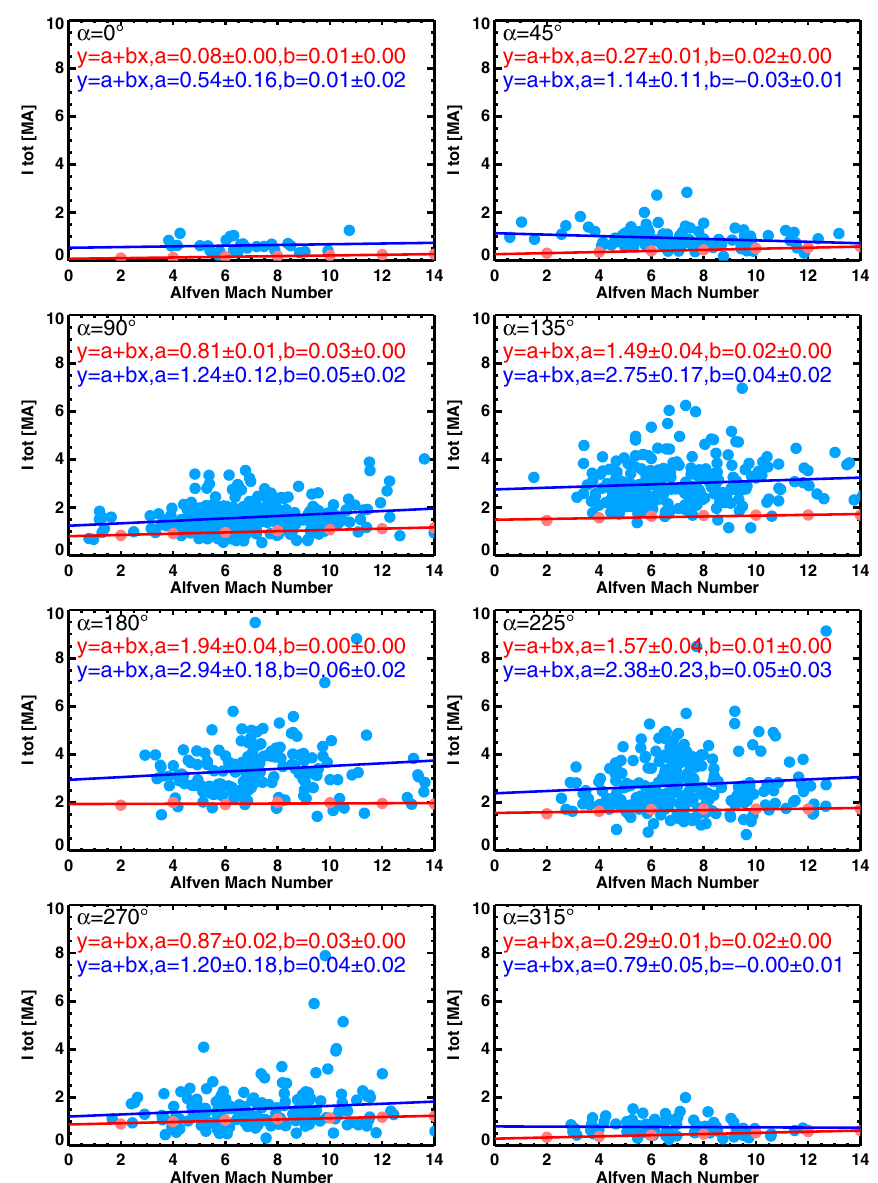
Fig. 9. Dependence of total current on solar wind Alfv´en Mach number, M A , and IMF clock angle, α , for the Iridium observations (blue dots) and the BATS-R-US plus RCM simulations (red dots). The lines of the respective color represent the linear least-squares fit functions noted at the top of each